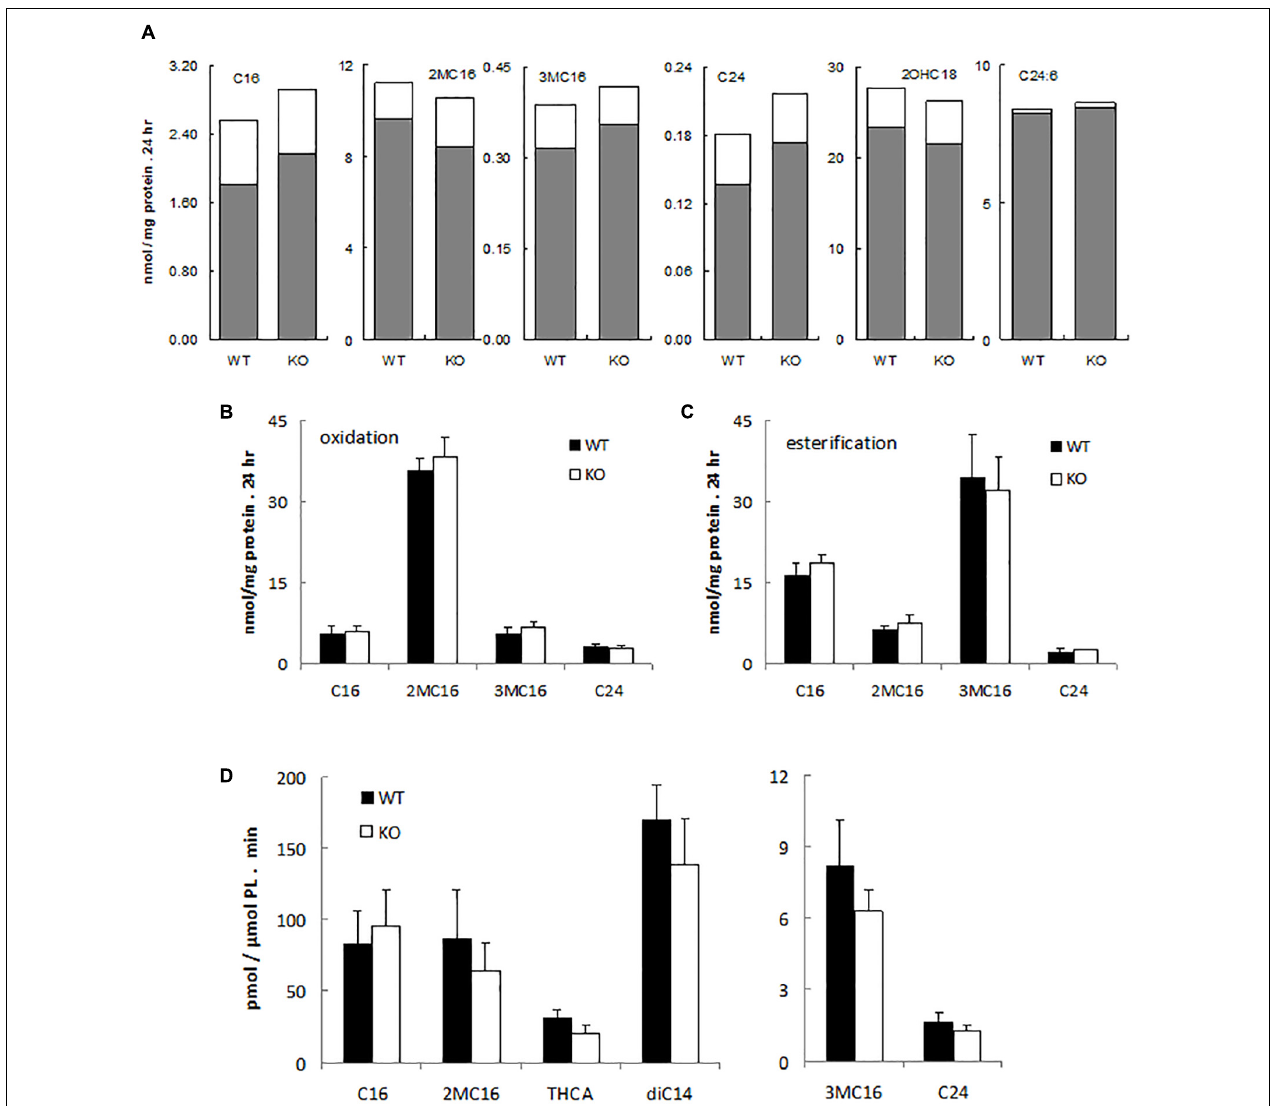
FIGURE 2 | α - and β -oxidation in PMP34 deficient cells. Primary MEF (A) , immortalized MEF (B,C) or liver slices (D) from wild type (WT) and PMP34 knockout (KO) embryos or mice were analyzed for α - and β -oxidation using 14 C-labeled substrates. Data for primary MEF (A) , derived from a single WT or KO E14.5 embryo (C57BL/6 background), are based on single incubations at 310-430 µ g protein/T25 falcon, followed by analysis of labeled oxidation products (white bars: CO 2 ; gray bars, acid soluble material or formate in case of 3-methylbranched fatty acids), normalized to protein content of the monolayer. Incorporation of fatty acids in glycerolipids and total uptake was comparable between the genotypes (not shown). Similar findings were obtained when incubations were done at other cell densities. Data for immortalized fibroblasts (B,C) , derived from 2 different embryos per genotype, are based on duplicate incubations at 110-180 µ g protein/T25 falcon, and expressed as mean ± SD. Oxidation (B) , normalized to protein, represent the sum of CO 2 and acid soluble material or to CO 2 plus formate in case of 3-methyl-branched fatty acids. Total uptake by fibroblasts, calculated as oxidation plus esterification, the latter representing the label recovered in cholesterylesters, triacylglycerols and phospholipids (C) , was not different between WT and KO cells. Data for liver slices (D) are based on duplicate incubations with slices derived from 3 male animals per genotype and represent the sum of CO 2 and acid soluble material or CO 2 plus formate in case of 3-methyl-branched fatty acids, expressed as mean ± SD (normalized to phospholipids, PL). For no substrate, differences in CO 2 or acid soluble material production were statistically significant except for THCA (* P < 0.05). Esterification rates for fatty acids were comparable (not shown). Dicarboxylic acids, 2-hydroxy long chain fatty acids, and bile acids are hardly or not incorporated into triacylglycerols and phospholipids, hence esterification of these substrates was not analyzed. C16, [1- 14 C]-hexadecanoic acid; 2MC16, 2-methyl-[1- 14 C]-hexadecanoic acid; 3MC16, 3-methyl-[1- 14 C]-hexadecanoic acid; C24, [1- 14 C]-tetracosanoic acid; 2OHC18, 2-hydroxy-[1- 14